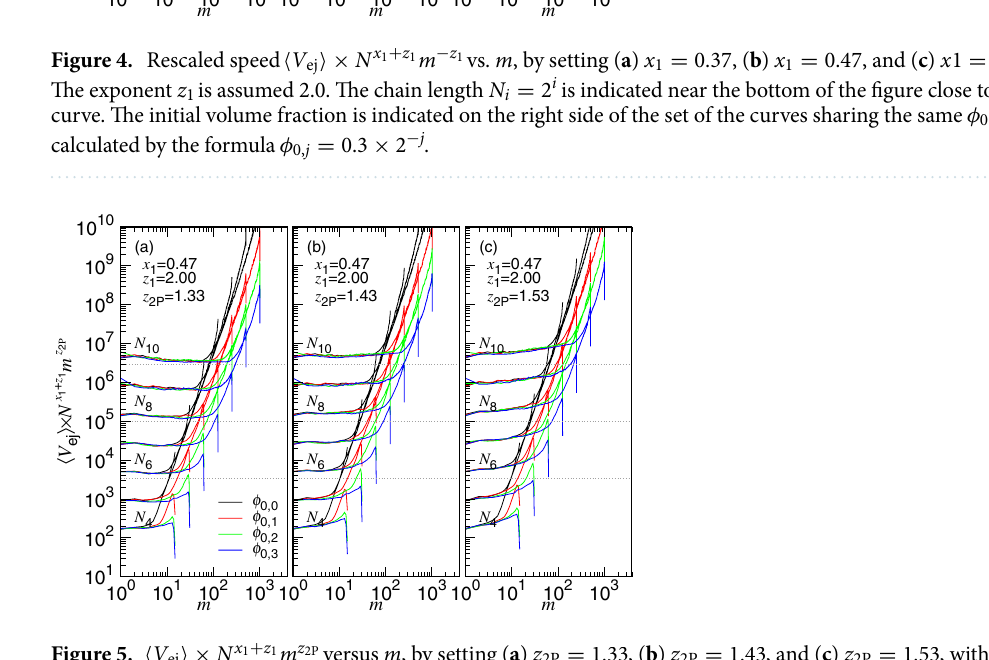
V ej N x 1 + z 1 m z 2P versus m , by setting ( a ) z 2P 1.33 , ( b ) z 2P Figure 5. � � × = 2 i is indicated on the left near the curve. The black, red, green, x 1 0.47 and z 1 2.0 . The chain length N i = = = φ 0, j with j 0 , 1, 2, 3, and blue curves have φ 0 = =